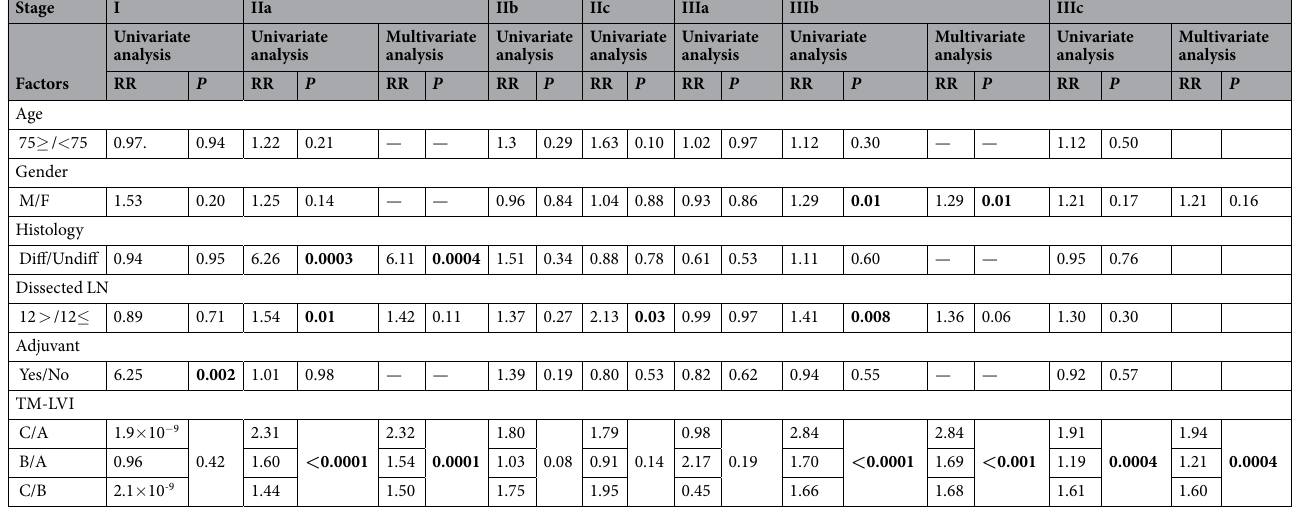
Table 2. Univariate and multivariate analysis for relapse-free survival of colon cancer was performed in each clinical stage. TM-LVI was an independent prognostic factor for relapse-free survival of colon cancer in stage IIa, IIIb, and IIIc. M/F, Male/Female; Diff/Undiff, Differentiated/Undifferentiated; LN, Lymph node; RR, Risk ratio; Bold type, P < 0.05.